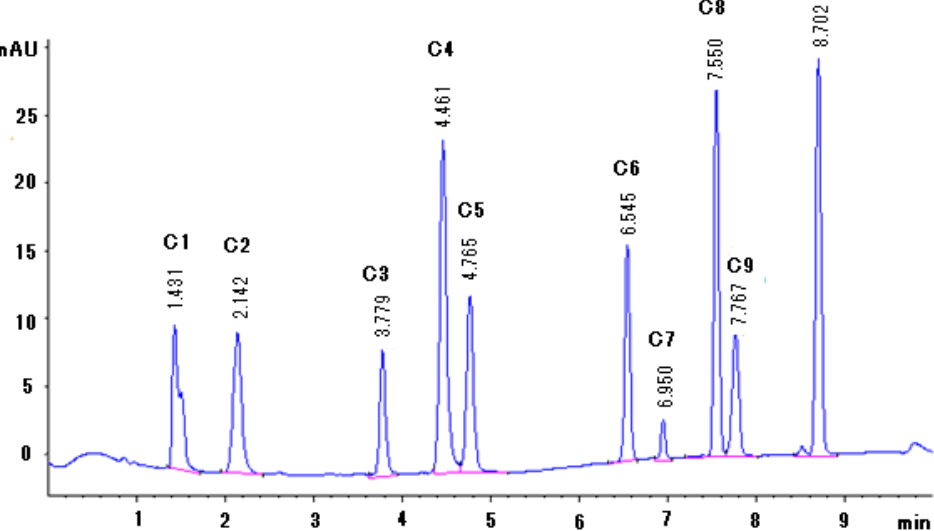
Figure 2. Chromatogram representing the separation of Compounds 1 – 10 using an XTerra ® MS C18 column (150 × 4.6 mm, 3.5 µm) under the conditions described in Section 3.3.